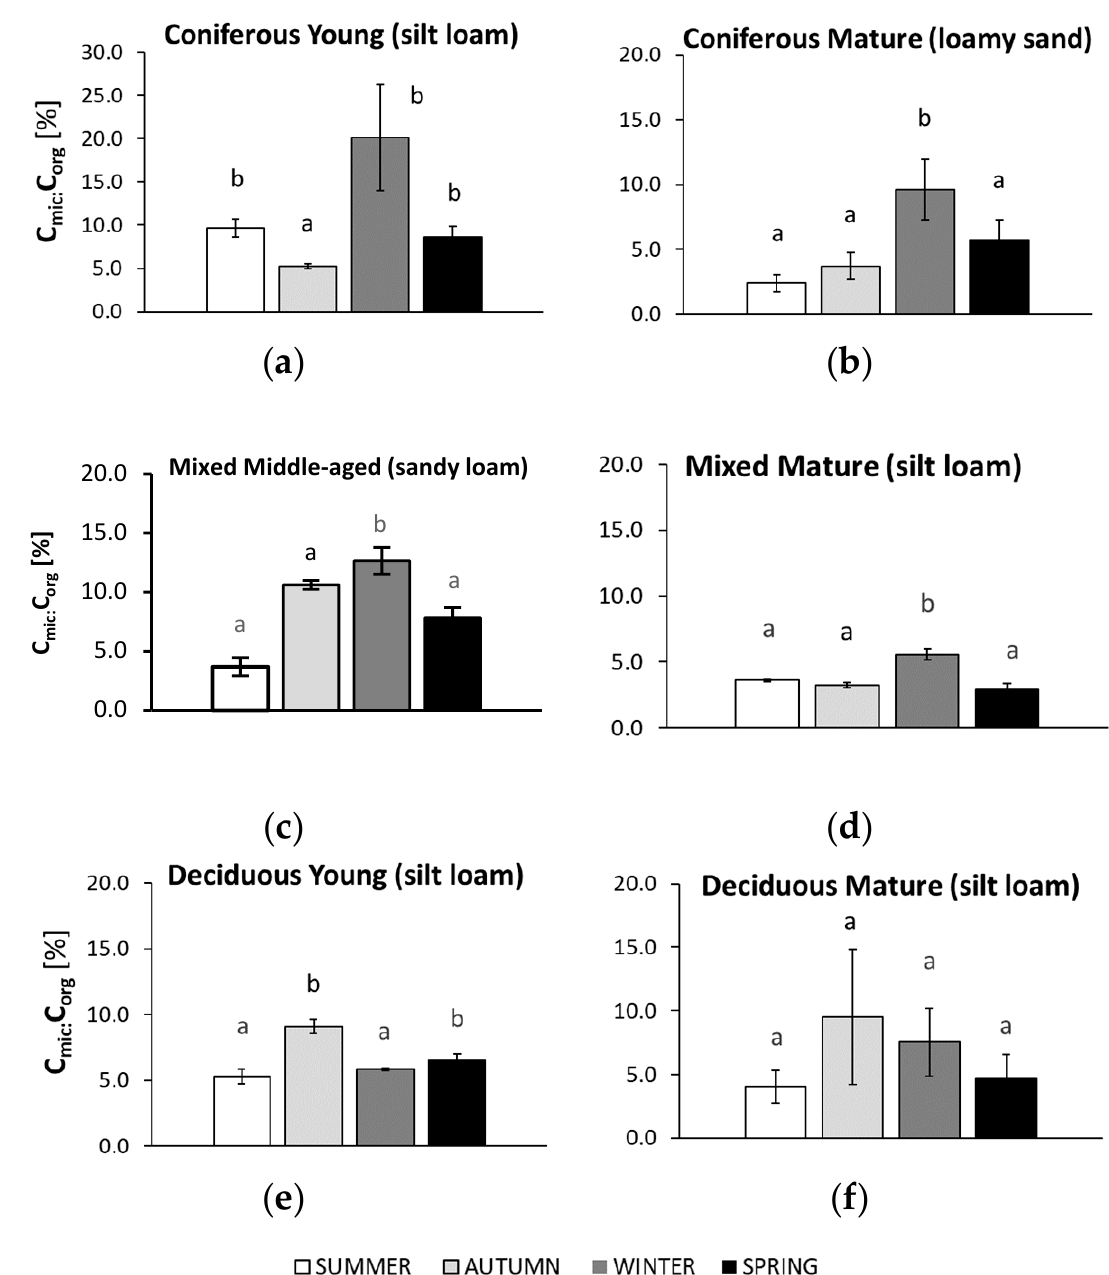
Figure 7. C mic :C org ratio in soil samples collected in summer, autumn, winter, and spring from different forests (average values ± standard deviation; n = 3). ( a ) Coniferous Young (silt loam); ( b ) Coniferous Mature (loam sand); ( c ) Mixed Middle-aged (sandy loam); ( d ) Mixed Mature (silt loam); ( e ) Deciduous Young (silt loam); ( f ) Deciduous Mature (silt loam). Different letters indicate significant differences (a non-parametric Kruskal–Wallis test, p < 0.05, was carried out separately for each season and for each forest).